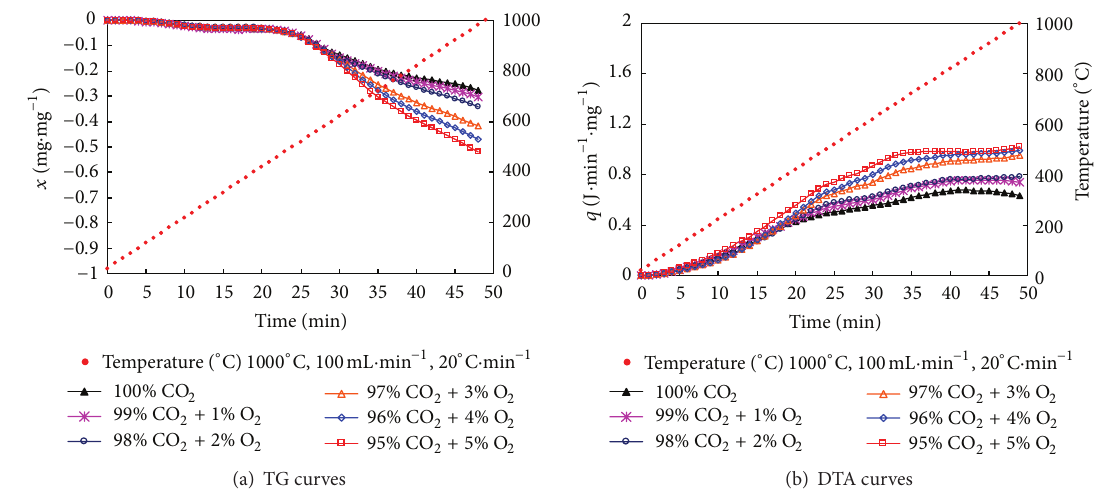
Figure 9: TG-DTA curves of different O 2 concentrations with a temperature of 1000 ∘ C.